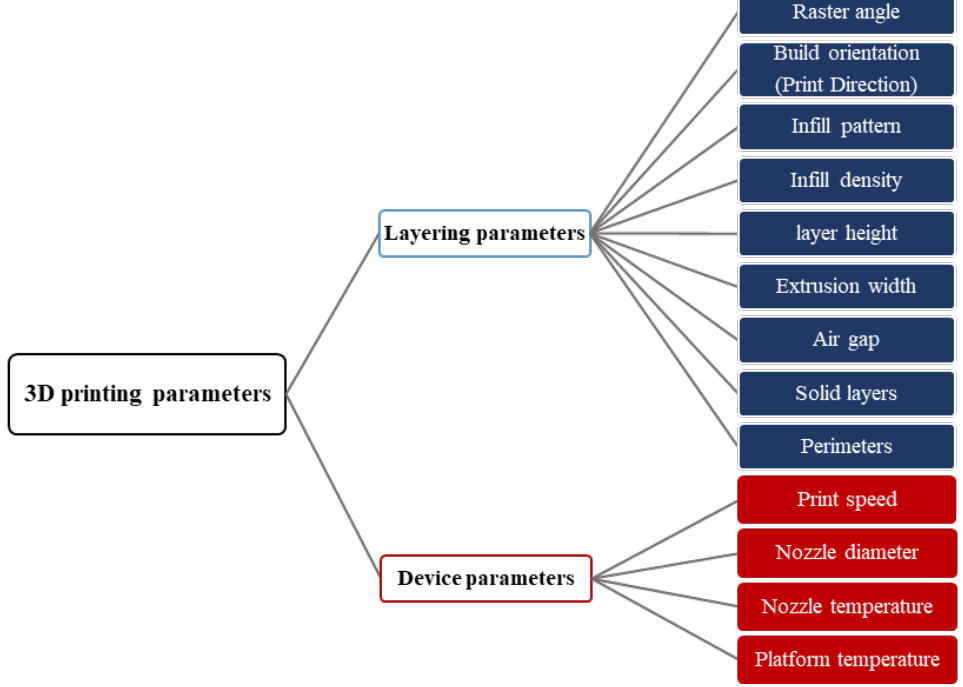
Figure 3. The 3D printing parameters influencing the mechanical properties of FFF prints.